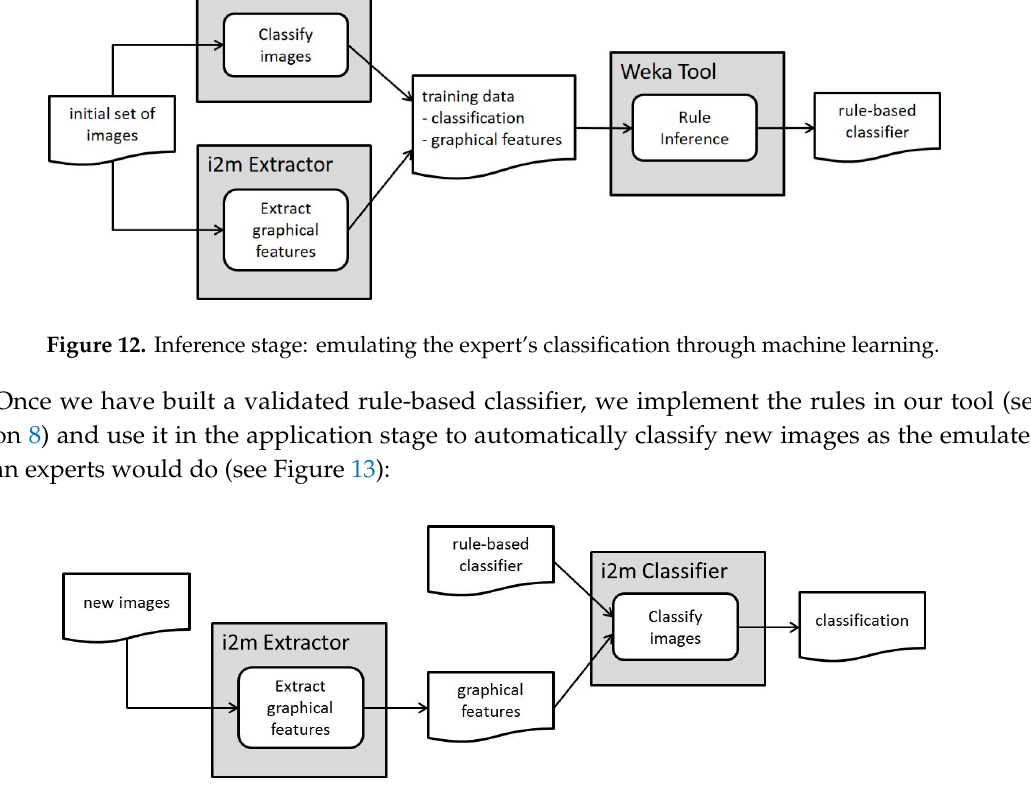
Figure 13. Application stage: classifying new images with the generated rule-based classifier